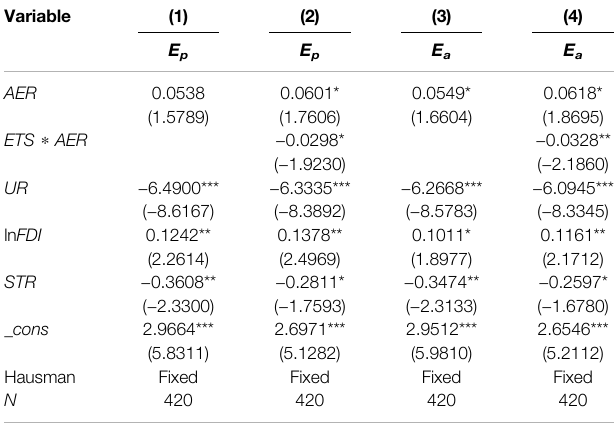
TABLE 5 | Interaction between carbon trading and voluntary environmental regulation on carbon decoupling.